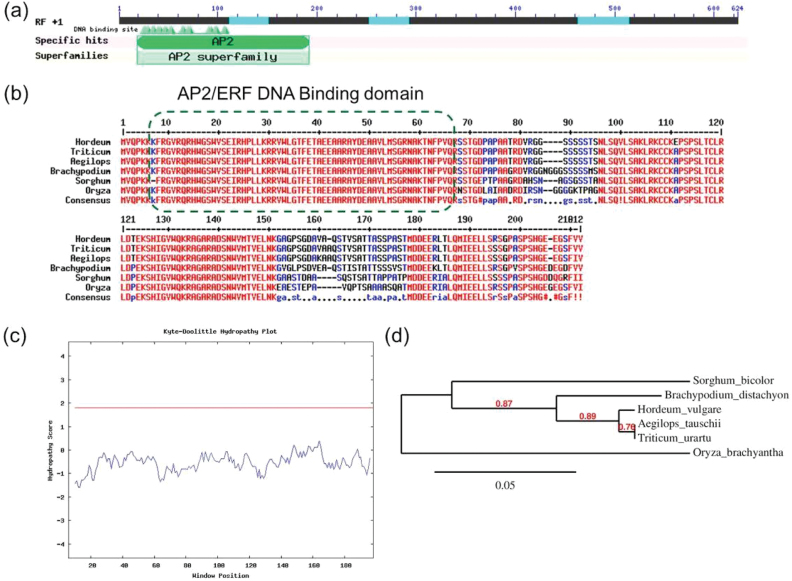

In silico analysis of HvWIN1. (A) Catalytic domain prediction by NCBI Conserved Domain Database Search. (B) Multiple sequence alignment of HvWIN1 from closely related plant species showing AP2/ERF DNA binding domain. (C) Hydropathy plot analysis at a window size of 19. Peaks with scores greater than 1.8 (horizontal line) indicate possible transmembrane regions. (D) Phylogenetic relationships of HvWIN1 with other plant WIN1 sequences retrieved from the NCBI database. The phylogenetic tree was built using the ‘à la carte’ function on the Phylogeny.fr server. A colour version of this figure is available at JXB online.